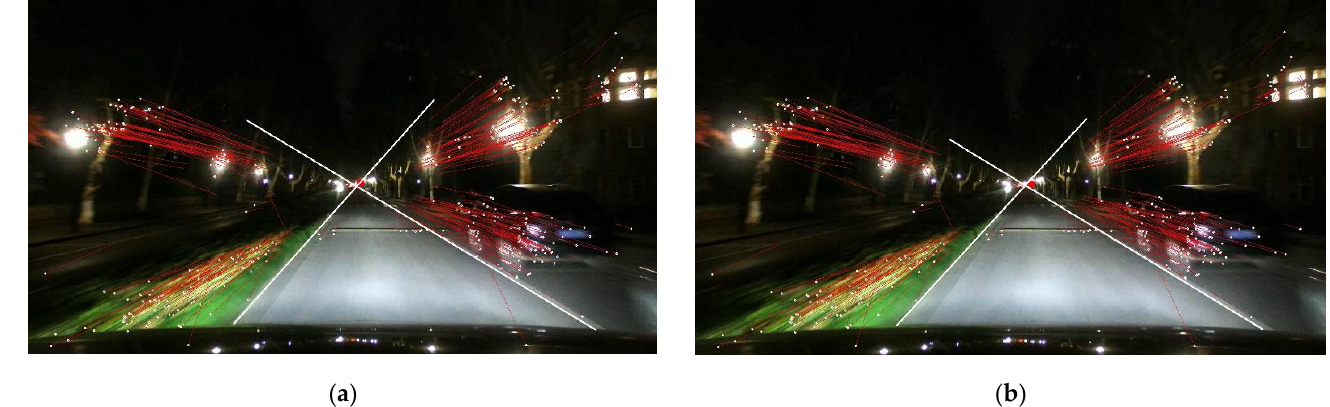
Figure 8. Detected R-VPs (indicated by red circles) and road boundaries drawing by hand (by white lines) under nighttime conditions using the proposed method applying reduction of type 2 and type 3, using ( a ) RANSAC iteration 900 and ( b ) iteration 45.